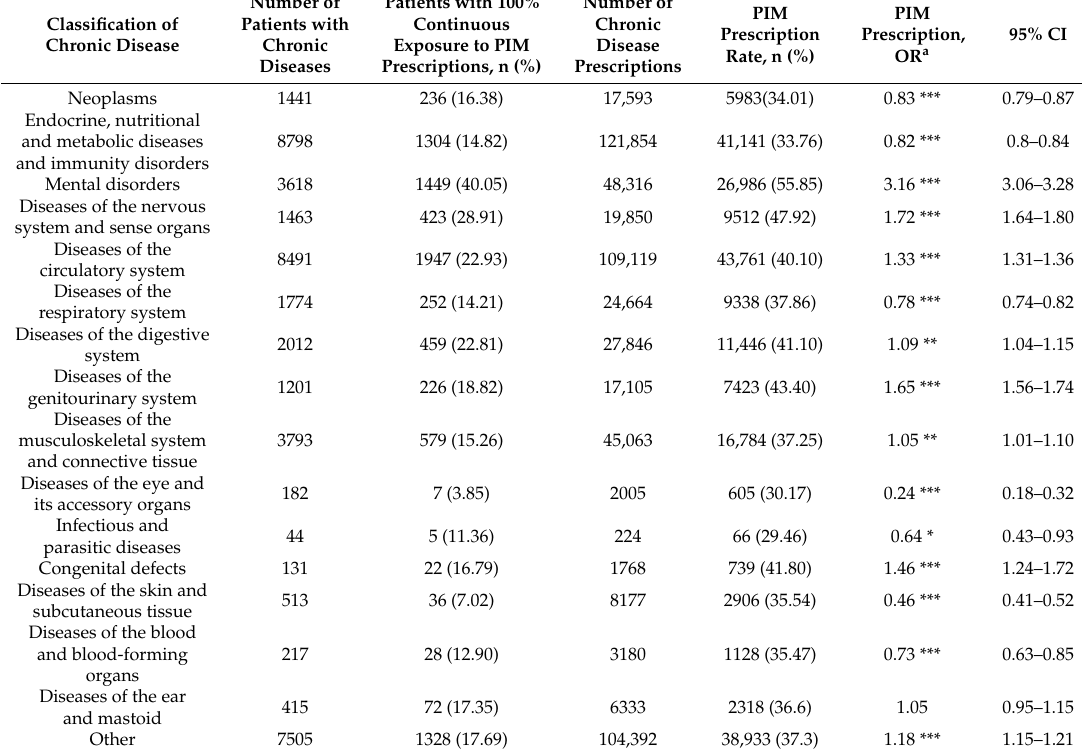
diseases (43.4%). Table 2. Comparison of 100% continuous exposure to PIM prescriptions, number of prescriptions, PIM prescription rate and OR by chronic disease